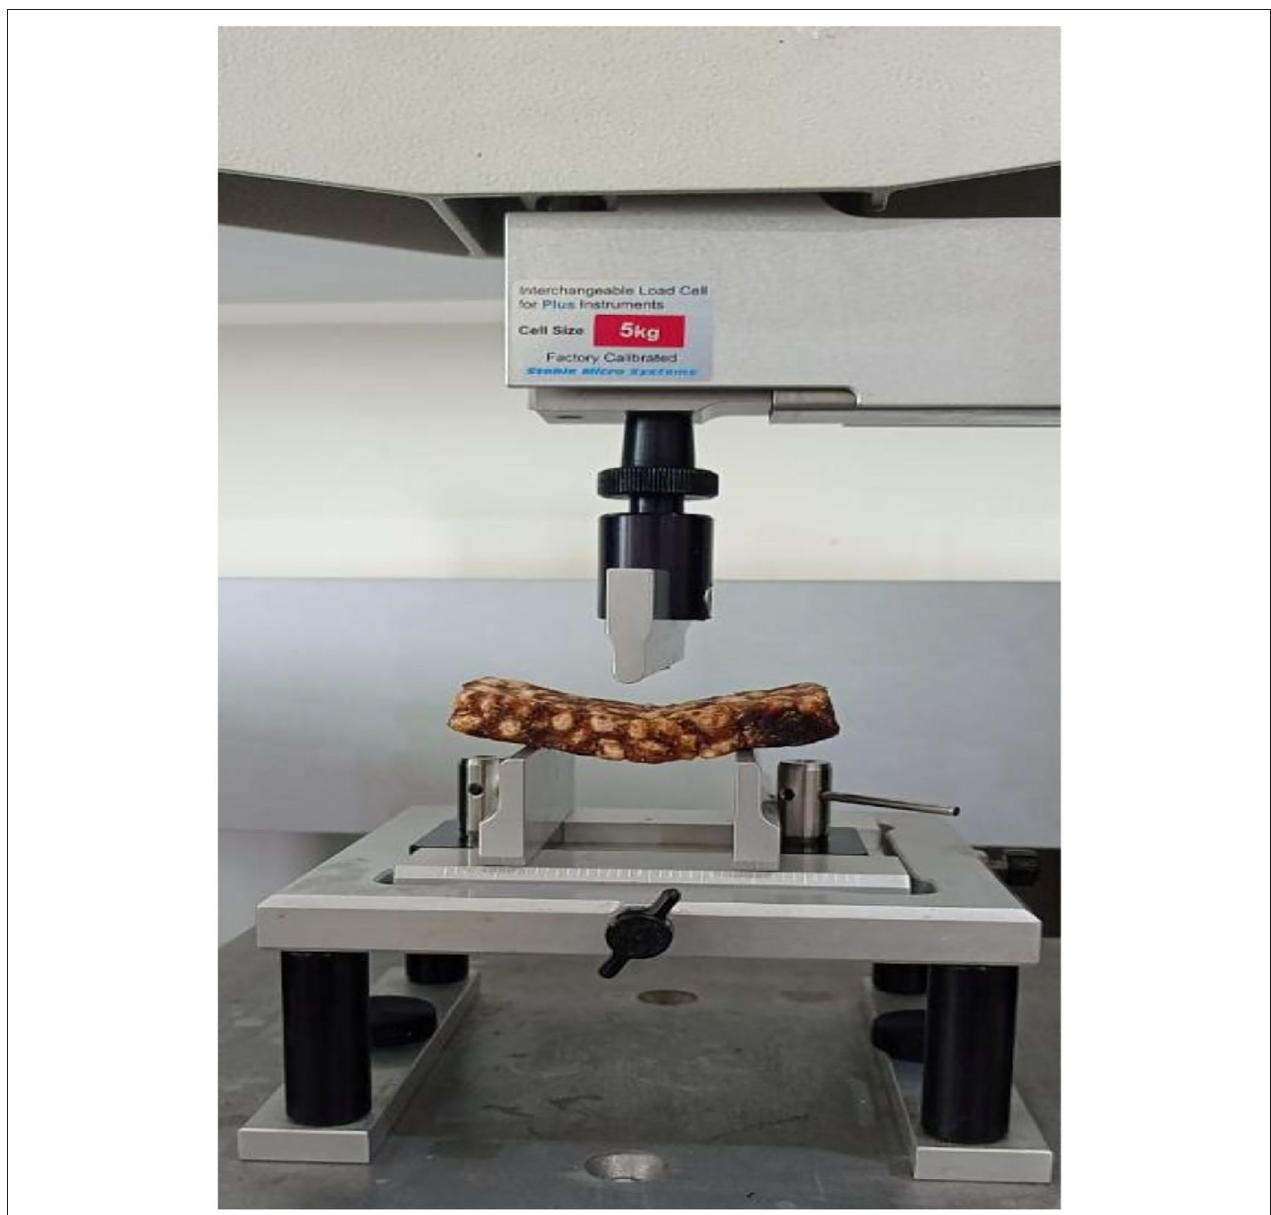
FIGURE 2 | Three point bending rig